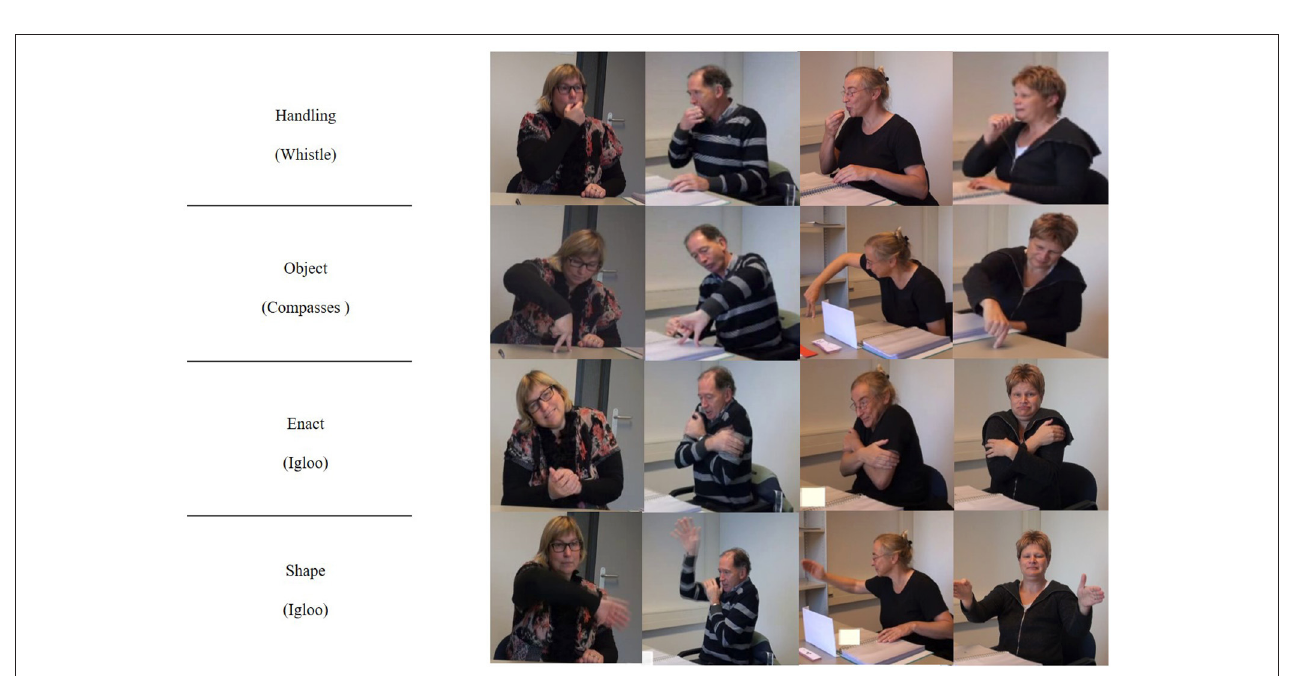
their depiction of an object. Those techniques, though, were not used by 80% or more of the participants and are thus not reported